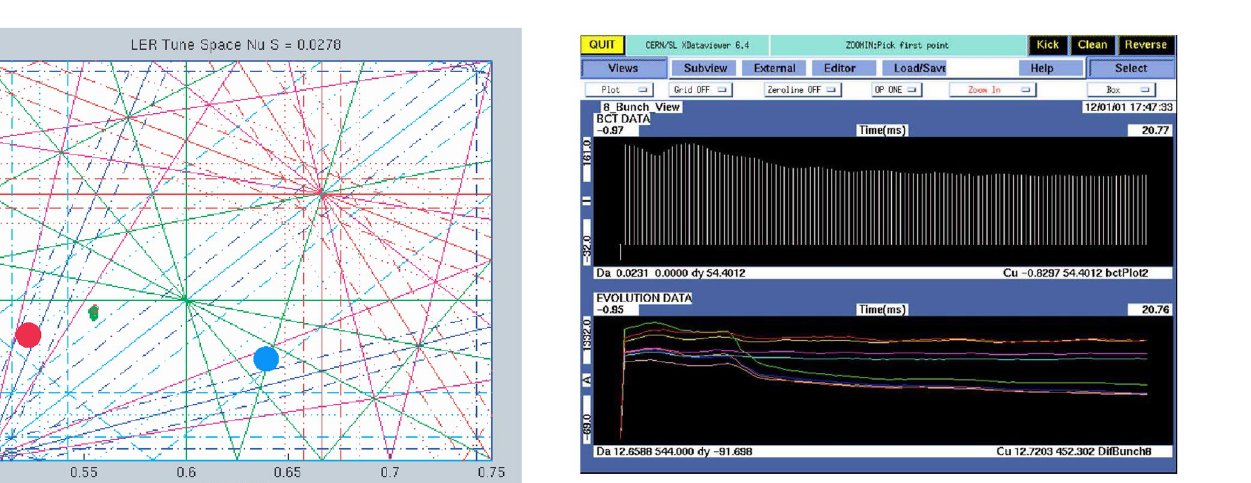
FIG. 19. (Color) Change in the PEP-II LER nominal working point from (cid:4) Qx; Qy (cid:5) (cid:3) (cid:4) 0 : 64 ; 0 : 56 (cid:5) (blue) to (cid:4) 0 : 52 ; 0 : 57 (cid:5) (red) on May 1, 2003